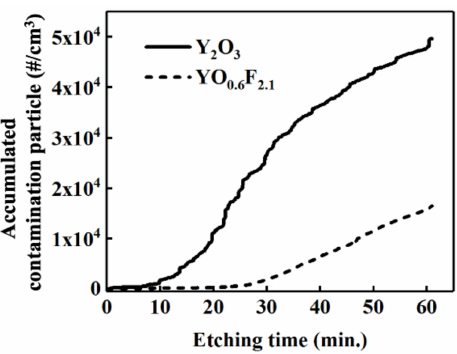
Figure 5. Real-time detection of accumulated contamination particle concentration, over 0.2 µ m size, generated from Y 2 O 3 and YO 0.6 F 2.1 during the 60 min NF 3 plasma treatment.